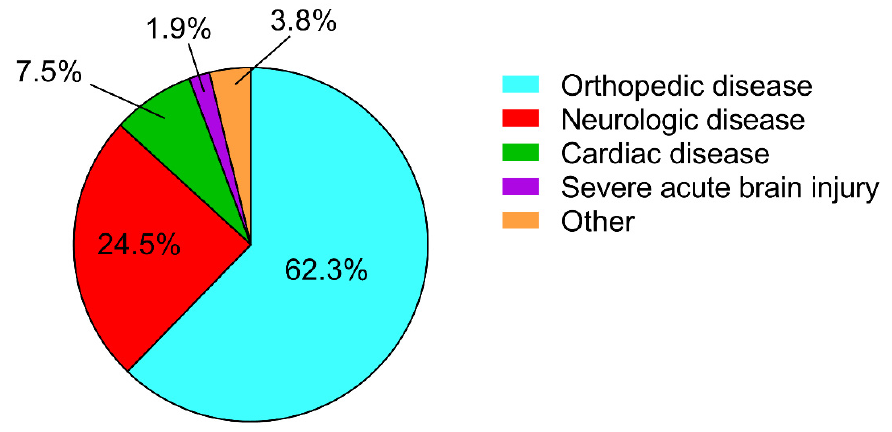
Figure 1. Patients’ diagnosis.